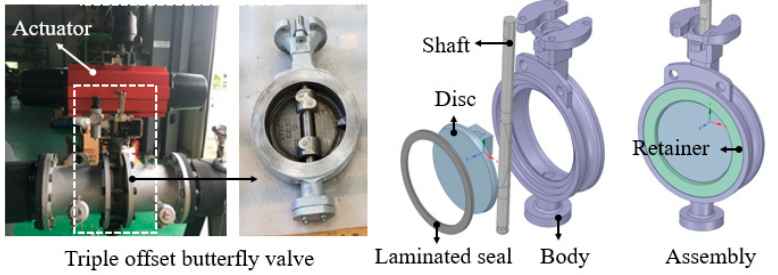
Figure 3. Structural of triple-offset butterfly valve.